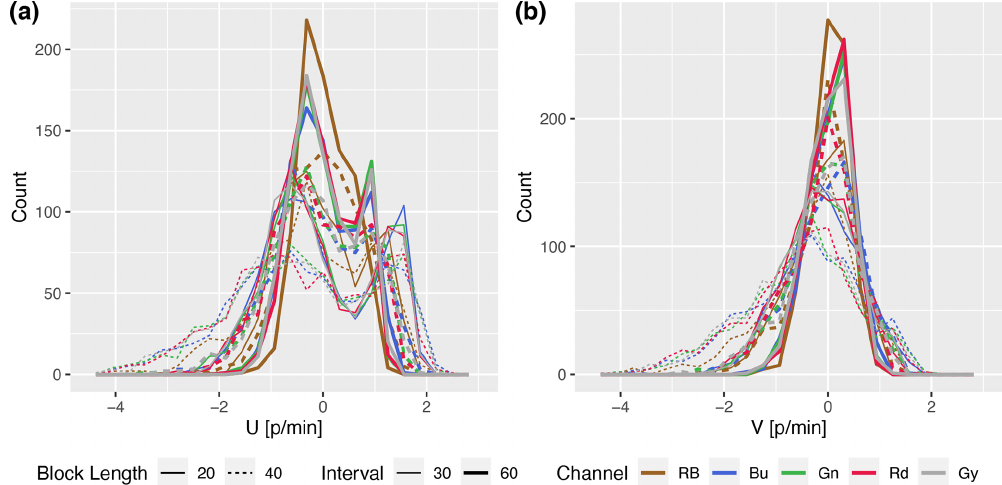
Figure 7. Frequency distributions of U and V components (pixel per min − 1 ) shown in Figs. 5 and 6, respectively, for all 20 setup combina- tions. The bimodal distribution of the U component is due to two cloud regimes discussed in Sect. 3.2.